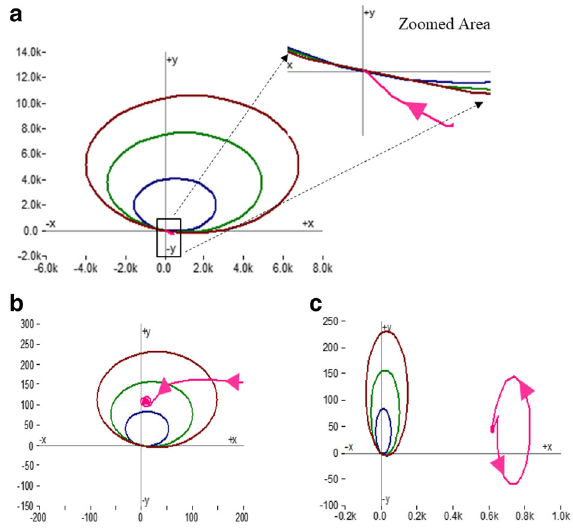
Fig. 7 Performance of ( a ) R 12 , ( b ) R 21 & ( c ) R 23 for LLG (RYG) fault at 500 km from Bus-1 (i.e. 150 km from Bus-2) with the proposed